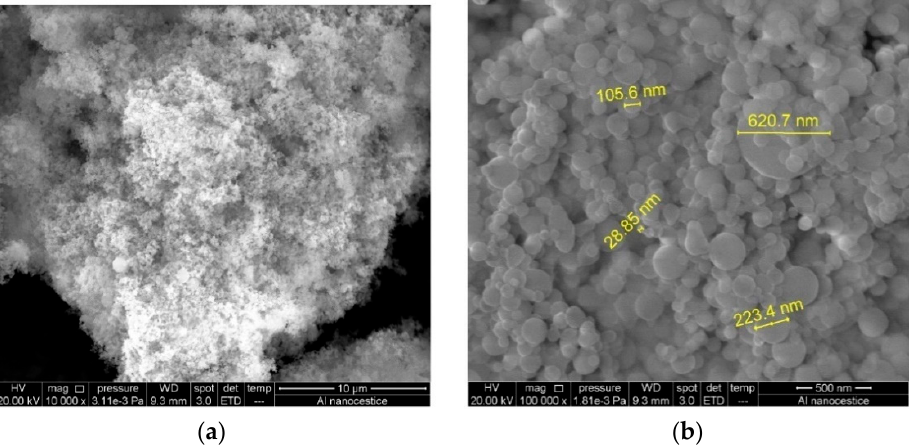
Figure 4 . SEM analysis of ( a ) Al NP surface morphology and ( b ) size of aluminium nanoparticles in metal powder.